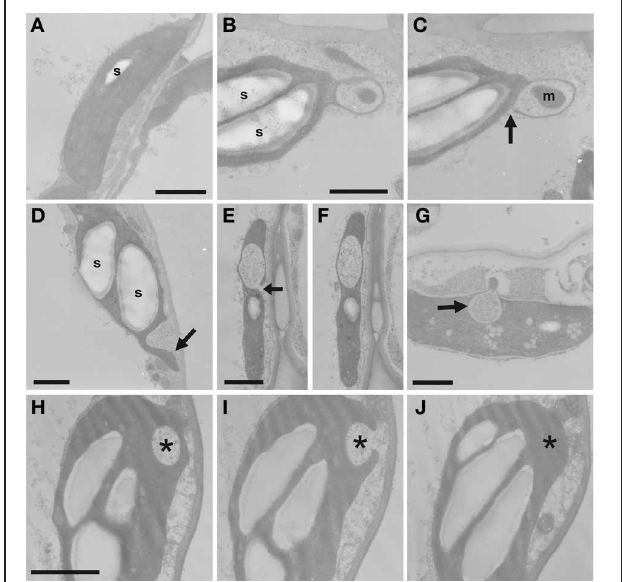
FIGURE 5 | Ultrastructural effects of PMTV infection on chloroplasts. Transmission electron microscope images of thin sections from a healthy N. benthamiana plant (A) , PMTV-infected N. benthamiana plants (B–F) and S. tuberosum cv. Scarborough (G–J) , the sections show ultrastructural changes in chloroplasts. (A) Example of a typical chloroplast from an uninfected N. benthamiana plant containing a single small starch grain (s). Bar = 1 μ m. (B,C) Sequential sections through a distorted chloroplast, from a PMTV-infected plant, containing large starch grains (s) and with a terminal, cytoplasmic inclusion encompassing a mitochondrion (m): in ( B) the inclusion appears enclosed, while in (C) it appears open with the aperture to the cytoplasm marked with an arrow. Bar in B = 1 μ m for ( B and C ). (D ) Chloroplast containing large starch grains (s) and with an abnormal, terminal extension (marked with arrow). Bar = 1 μ m (E,F ) Serial sections through a chloroplast of an epidermal cell with a cytoplasmic inclusion: the inclusion appears open in (E) (aperture marked with an arrow) and enclosed in (F) . Bar in E = 1 μ m for (E and F). (G) Chloroplast with large cytoplasmic inclusion (marked with an arrow) from PMTV-infected potato plant. Bar = 1 μ m. (H,I,J) Serial sections through a chloroplast from a potato plant infected with PMTV: in (H) , the inclusion ( ∗ ) appears enclosed, while it is open in (I) and missing from (J) , indicating the open flask-shaped nature of these inclusions. (Bar in H = 1 μ m for H–J